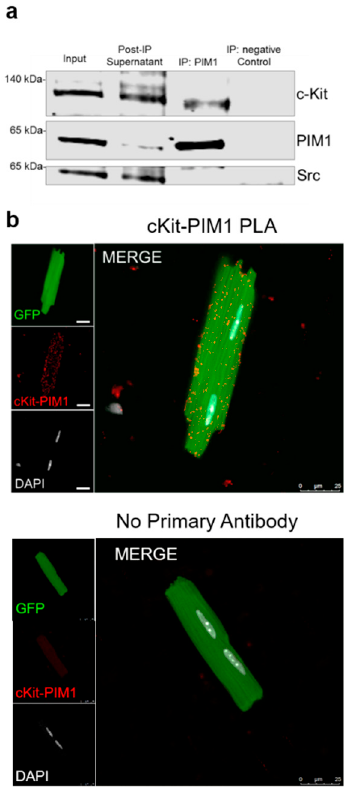
Figure 2. PIM1 interacts with c-Kit. ( a ) Immunoblot analysis of a co-immunoprecipitation using whole heart lysates from PIM1 hearts in which PIM1 was pulled down. ( b ) Interaction between PIM1 and c-Kit as determined by proximity ligation assay (top panel) and in the absence of primary antibody (bottom panel). Proximity events are shown as red dots.